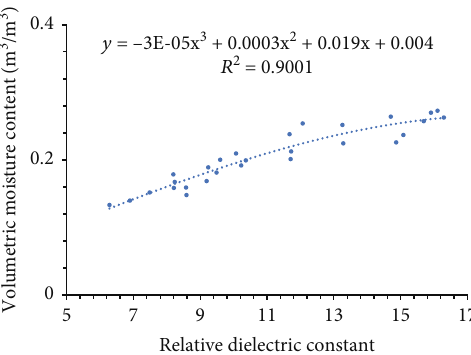
Figure 14: The fi tting relationship between relative dielectric permittivity and volumetric water content of sample.